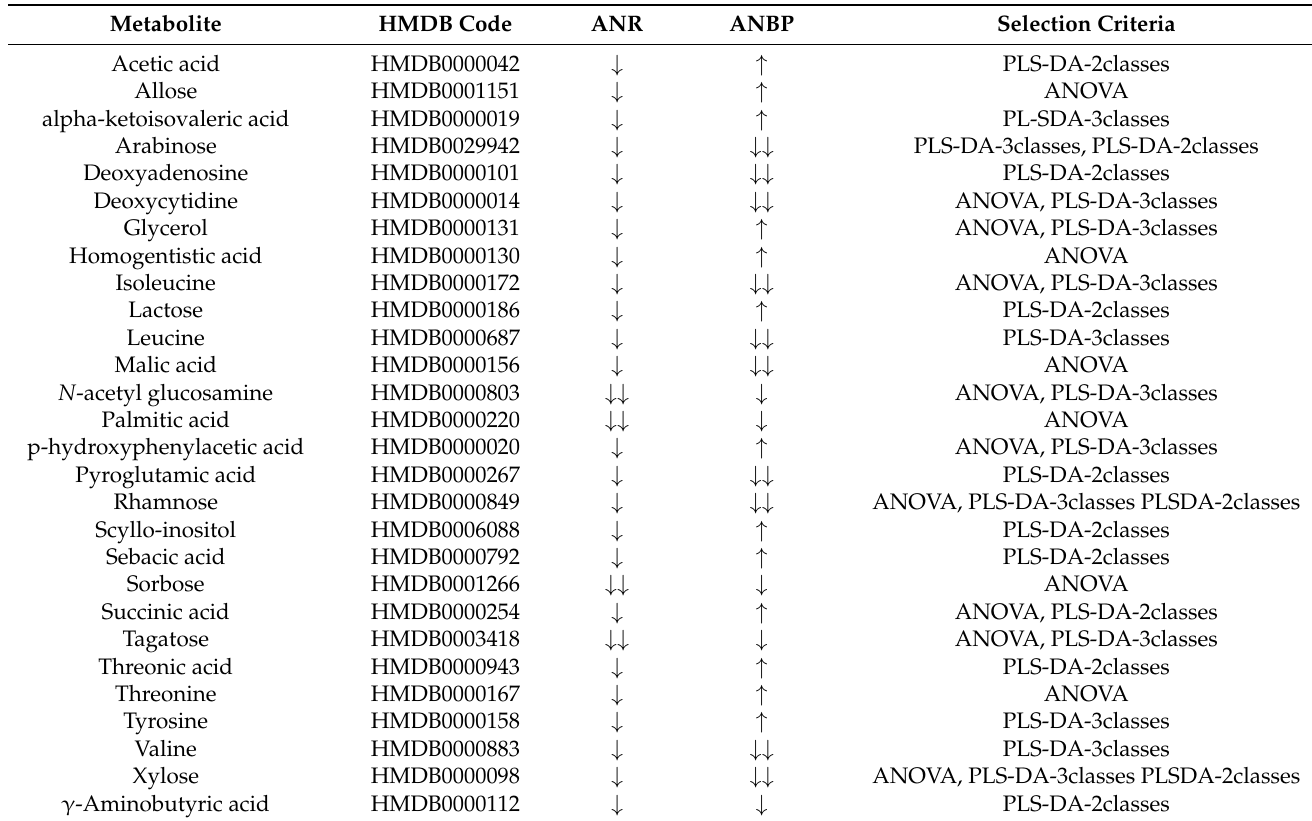
Table 2. Fecal metabolite changes with respect to healthy controls in women with restrictive anorexia nervosa (ANR) and binge-purging anorexia nervosa